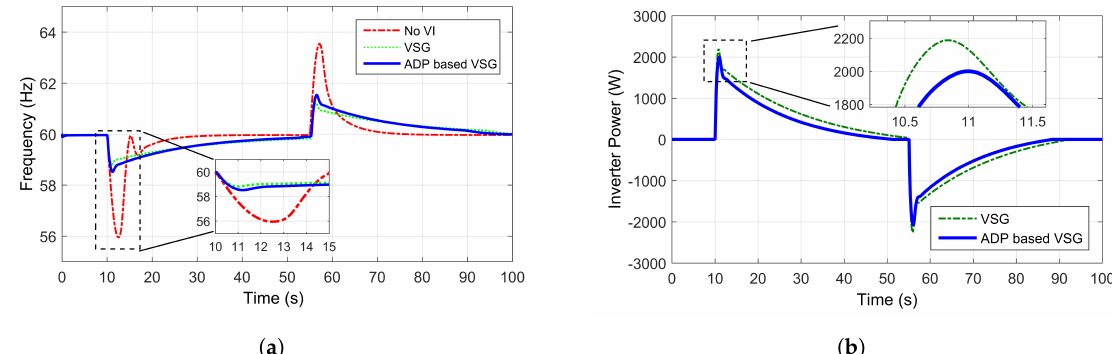
Figure 16. Comparison of traditional virtual synchronous generator (VSG) controller with the online learning based controller: ( a ) frequency of the system for step load changes; ( b ) power exchange with the system (Adapted from [91]). Table 3. Performance comparison of the system without virtual inertia (VI), simple virtual